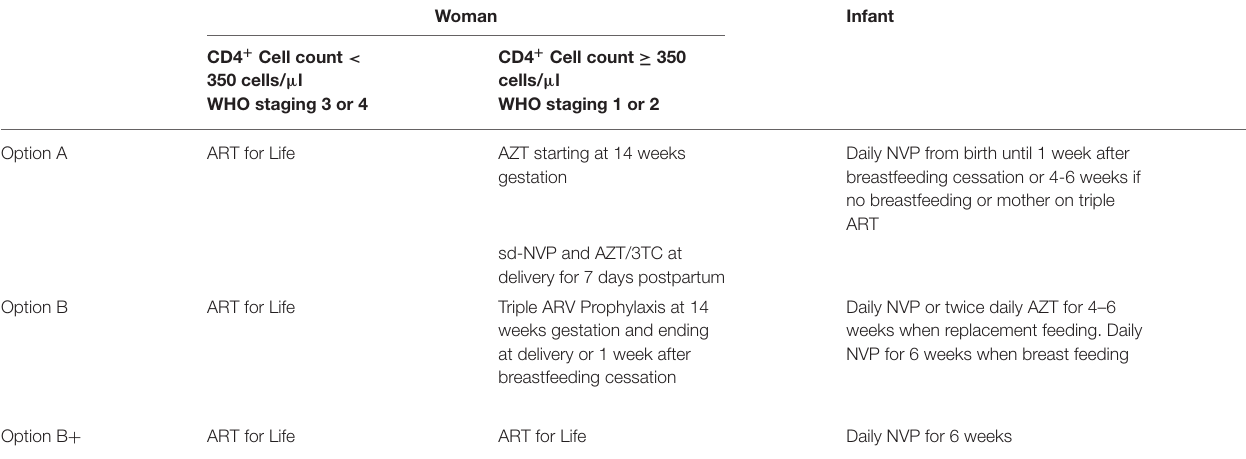
TABLE 1 | Treatment algorithm and transition of PMTCT strategies in Zambia for HIV positive women and their exposed